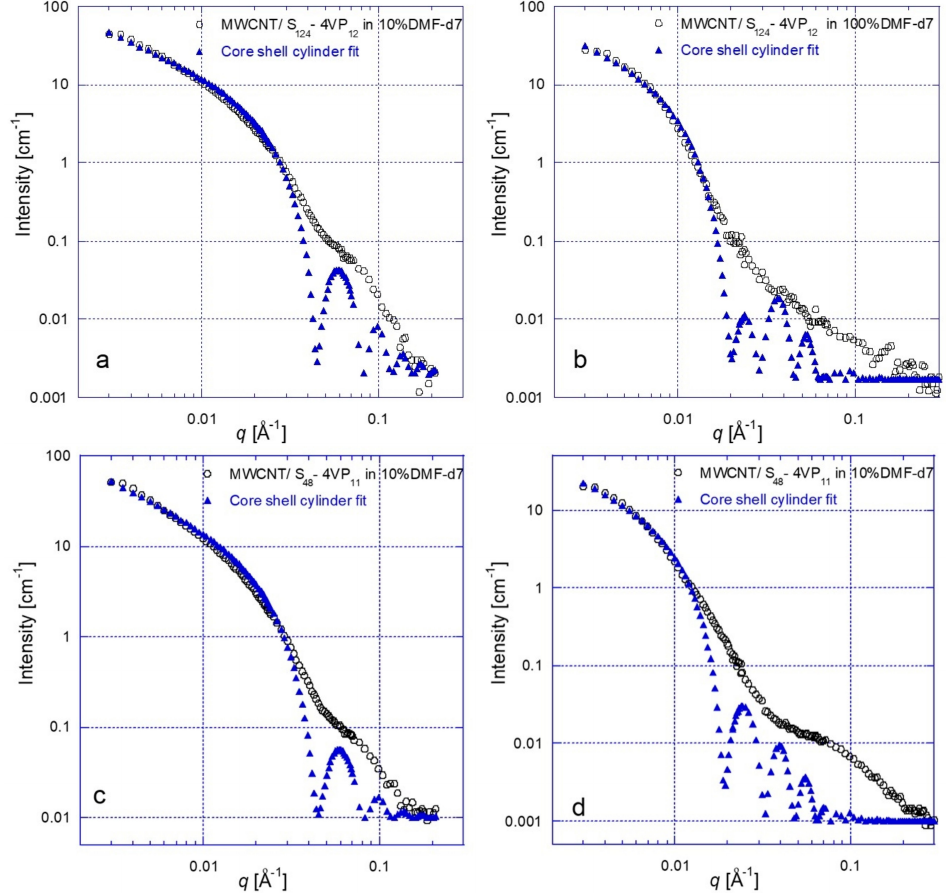
Figure 14. A core–shell cylinder model fit to the scattering data (background subtracted) of 0.5 wt.% MWCNT + 1 wt.% S 124 -4VP 12 ( a , c ) and of 0.5 wt.% MWCNT + 1 wt.% S 48 -4VP 11 ( b , d ), in 10 wt.% DMF-d7 ( a , b ) and 100% DMF-d7 ( c , d ) solvent